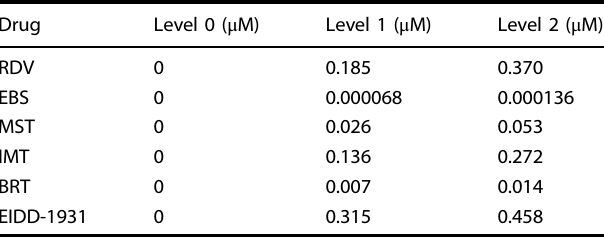
Table 2. Clinically actionable drug concentrations for the IDentif.AI-x drug combination